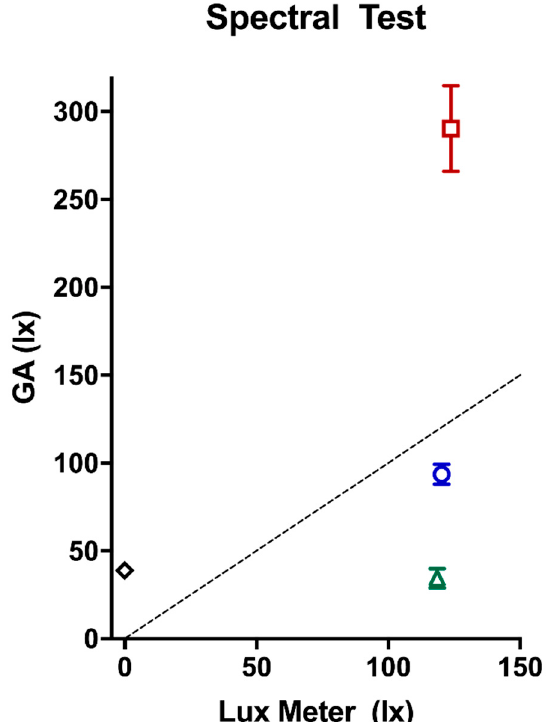
Figure 3. GENEActiv output under ~120 photopic lux with varying wavelength: red (630 nm), blue (470 nm), and green (520 nm), with error bars (standard deviation from the mean). Diamond indicates GENEActiv output under infrared light at 0 lux (note the error bars for infrared are very small and therefore di ffi cult to see; see Table 3). The dotted line indicates perfect agreement between the lux meter and GENEActiv output. Table 3. Summary statistics across n = 10 GENEActiv devices under blue, red, green, and infrared light conditions. Lux